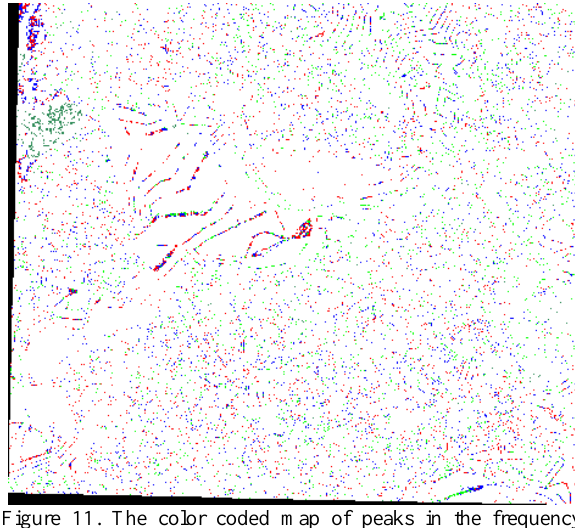
Figure 11. The color coded map of peaks in the frequency distribution of the differential